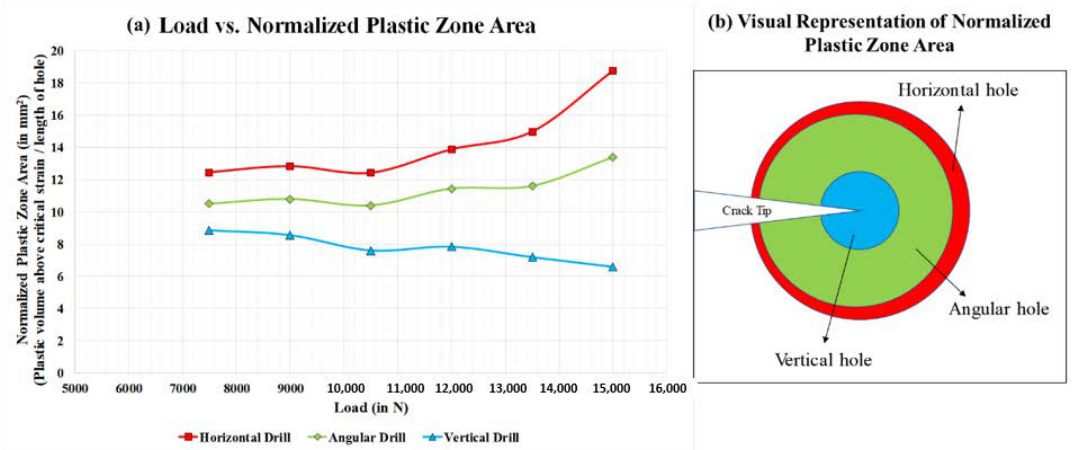
Figure 7. ( a ) Development of normalized plastic zone area with load for di ff erent drill hole orientations and ( b ) a visual representation of the normalized plastic zone area around the drill hole (considering it to be a crack) at 15,000 N compressive